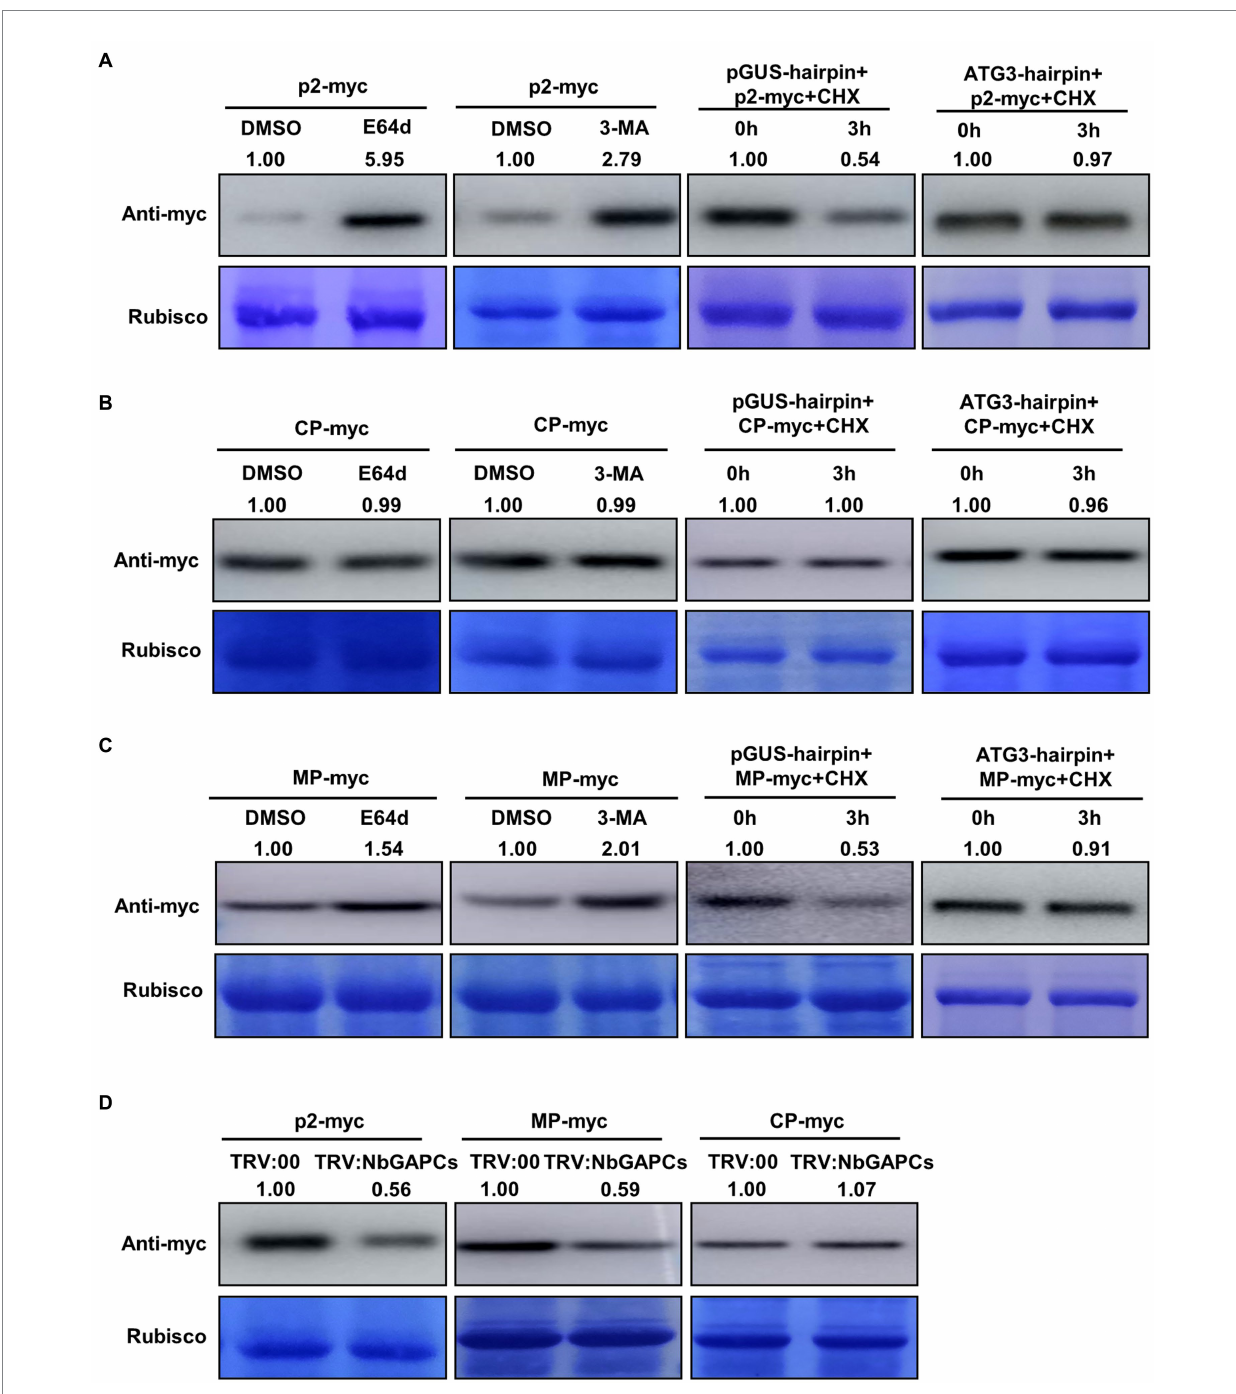
FIGURE 2 p2 protein is targeted by autophagy for degradation. (A) Treatment with the autophagy inhibitors, E-64d and 3-MA, increased the accumulation of RFP-fused p2 protein (p2-myc). Leaves expressing p2-myc by agroinfiltration at 48 hpi were further treated with DMSO, E-64d or 3-MA for 12 h. Total proteins were then extracted for Western blot. Rubisco large subunit was used as a loading control. Silencing of NbATG3 blocked the degradation of p2. Accumulation of p2-myc was reduced at 3 h post infiltration of CHX in the control leaves expressing GUS-hairpin, indicating the degradation of p2-myc (left panel), while it was not in leaves expressing NbATG3-hairpin. (B) Results using RSV coat protein (CP) as the negative control showing that it was not targeted by autophagy for degradation. (C) Results using RSV movement protein (MP) as the positive control since this protein has been reported to be degraded through autophagy. (D) Silencing of NbGAPCs reduced the accumulation of p2. Accumulation of p2-myc was reduced in plants infected with TRV:NbGAPCs compared to that in the control (TRV:00-infected) plants. Two typical replicates in each experiment are shown. Band intensity in blots was calculated by ImageJ from at least three